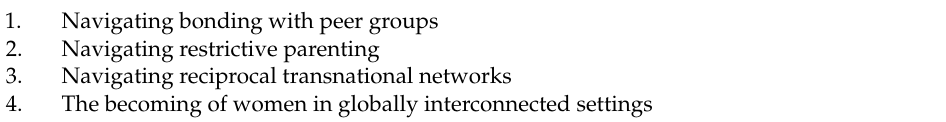
(Table 2): navigating bonding with peer groups; navigating restrictive parenting; reciprocal transnational networks; and the becoming of women in globally interconnected settings. Table 2. Overview of the four